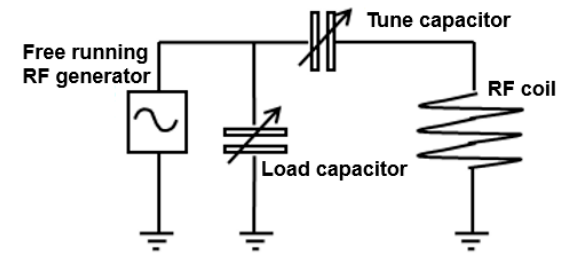
Figure 8. Highly simplified schematic of fixed match RF network.